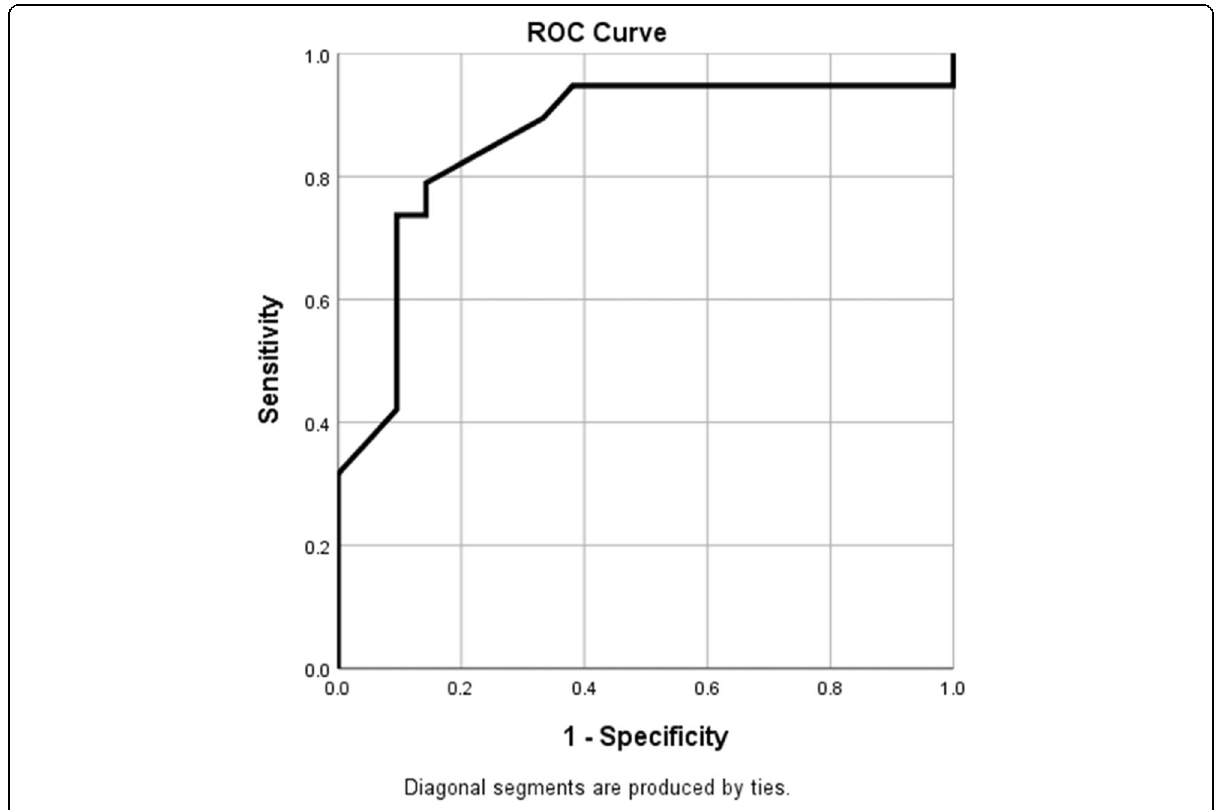
Fig. 7 Results of receiver operating curves for ADC values in distinguishing non-viable and viable treat lesions